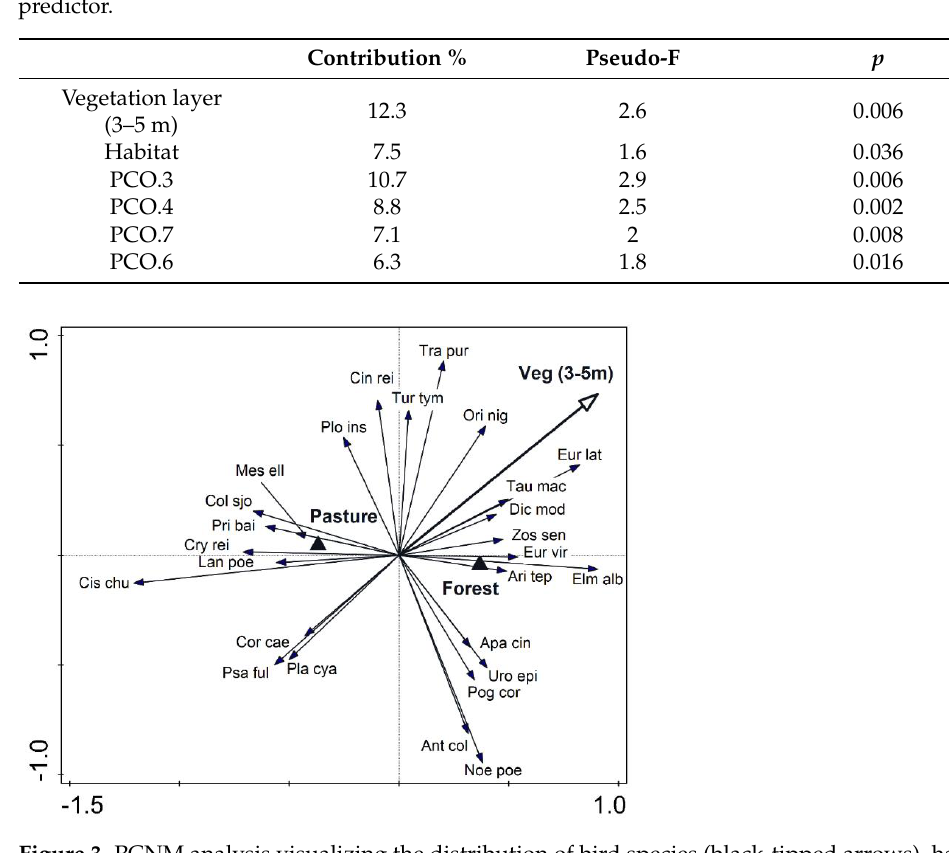
Figure 3. PCNM analysis visualizing the distribution of bird species (black-tipped arrows), habitat (triangles), and the vegetation (3-5 m, white-tipped arrow) in the space of the two axes indicating the valuable habitat type within a bird community in the tropical rainforest of Mount Cameroon.